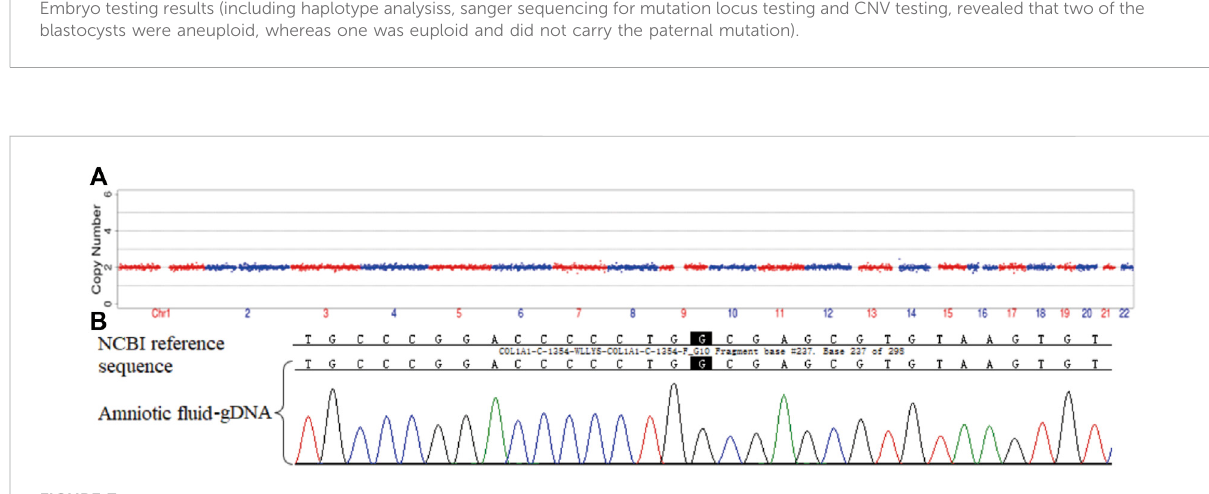
FIGURE 7 Prenatal diagnosis by amniocentesis at 20 weeks of gestation. CNV (A) and genetic testing (B) results for amniotic fl uid-derived